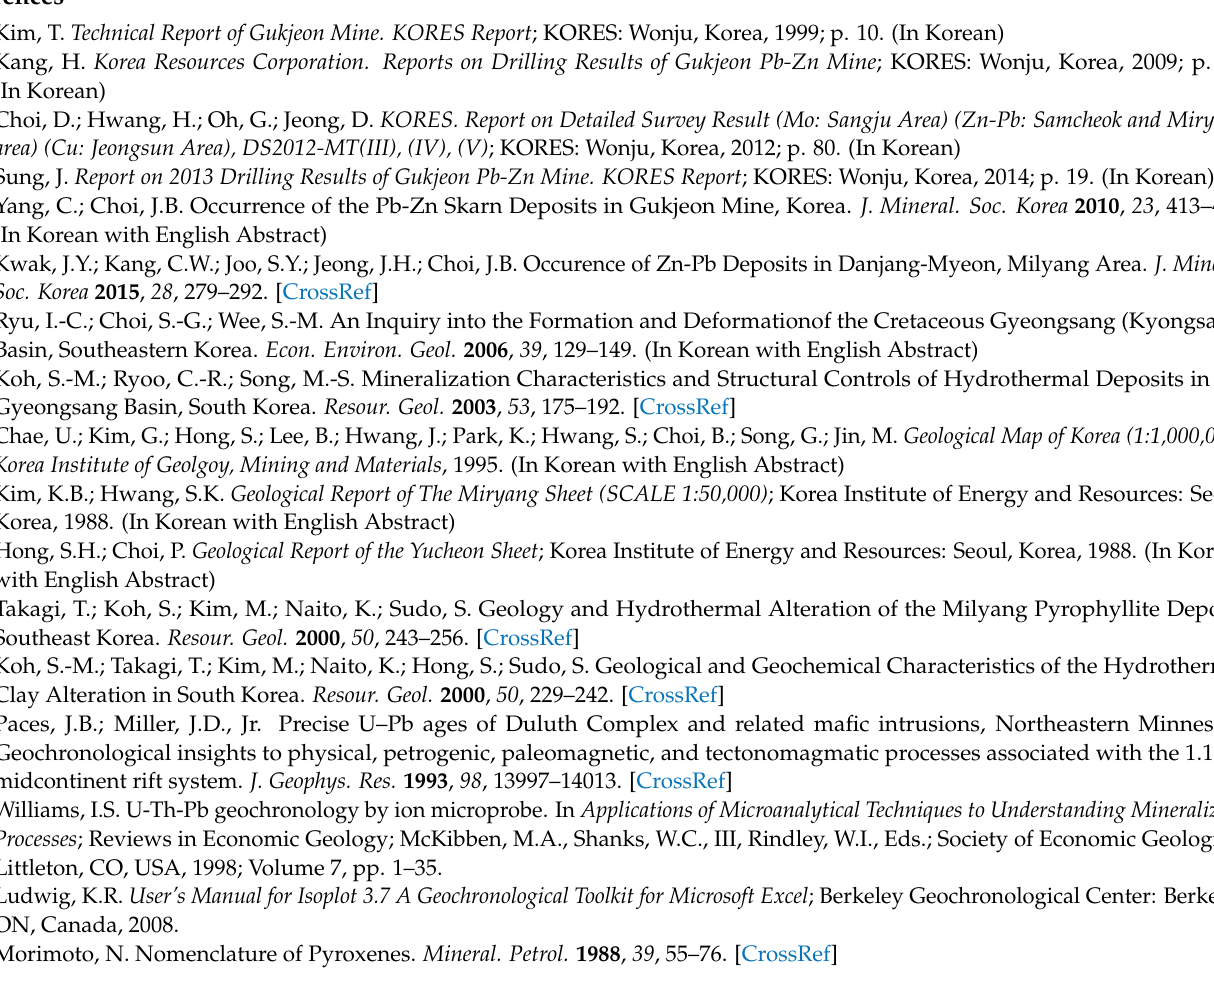
EPMA analytical results for garnet. Table S5: EPMA analytical results for amphibole. Table S6: EPMA analytical results for axinite. Table S7: EPMA analytical results for